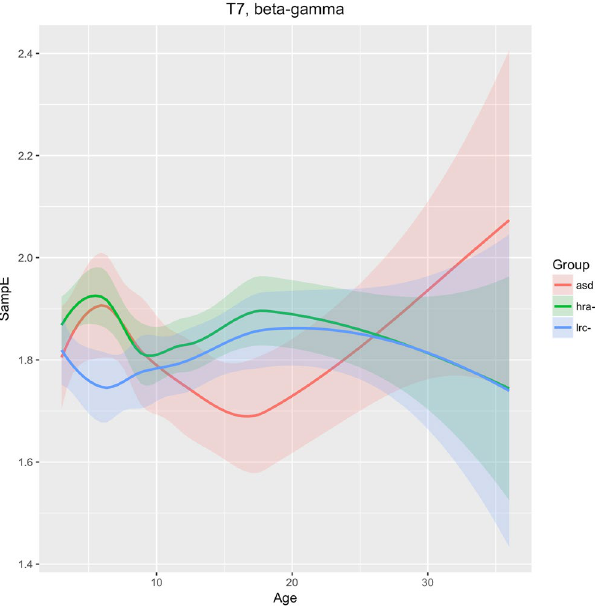
Figure 8. Developmental trajectories for SampE in the left temporal region (T7 sensor) in higher frequencies (beta + gamma) for ASD, LRC − , and HRA −